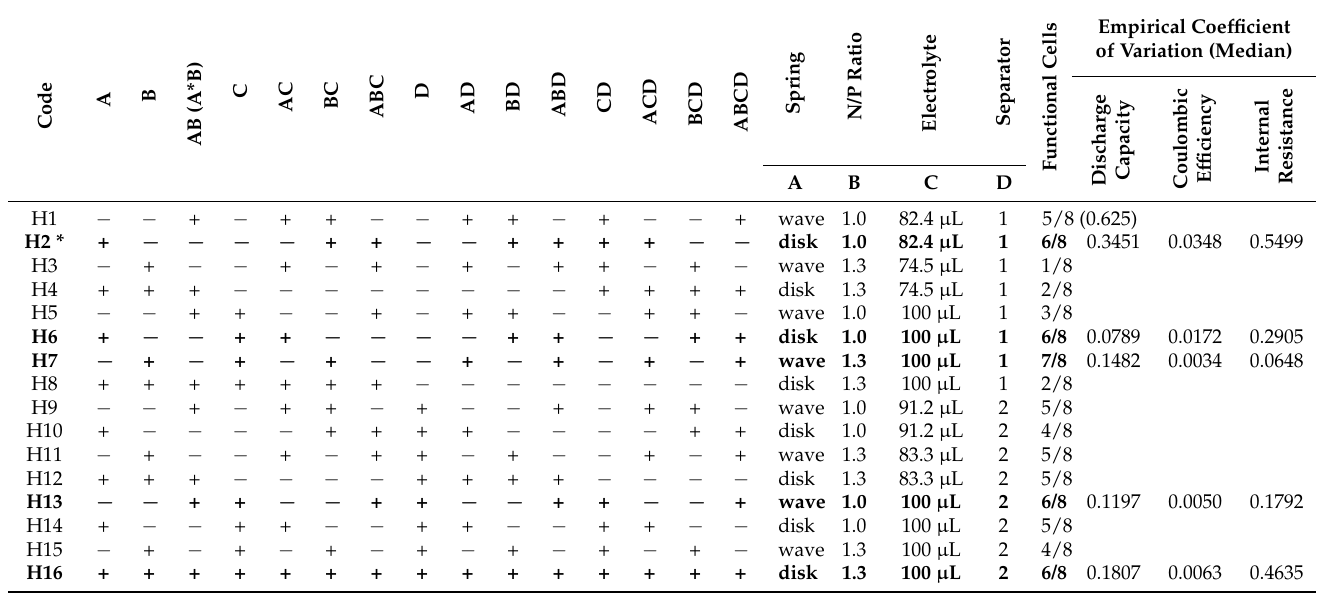
Table 5. Full factorial design matrix for material impact on coin cell